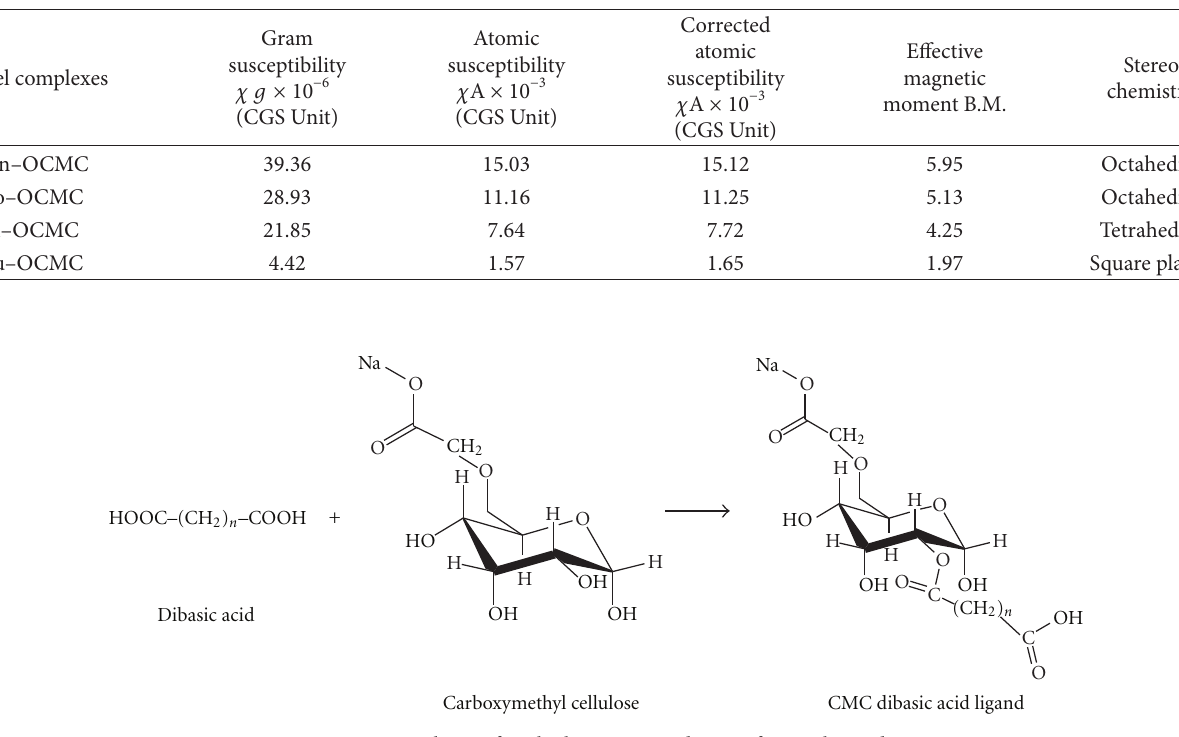
T 3: Magnetic moment data of OCMC Metallic Gel